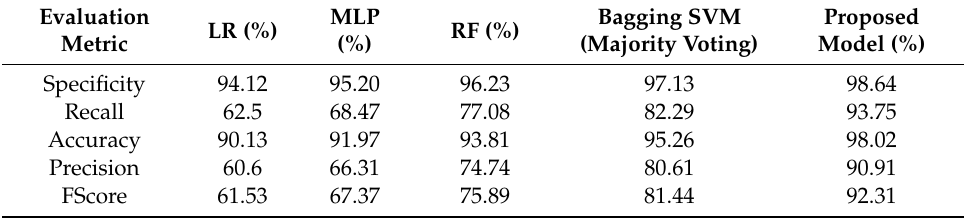
Table 8. Comparison of evaluation metrics of the proposed model with other